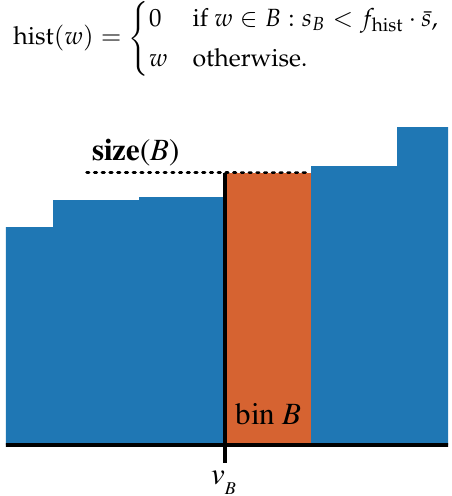
Figure A1. The ‘hist’ method concepts visualized using a histogram